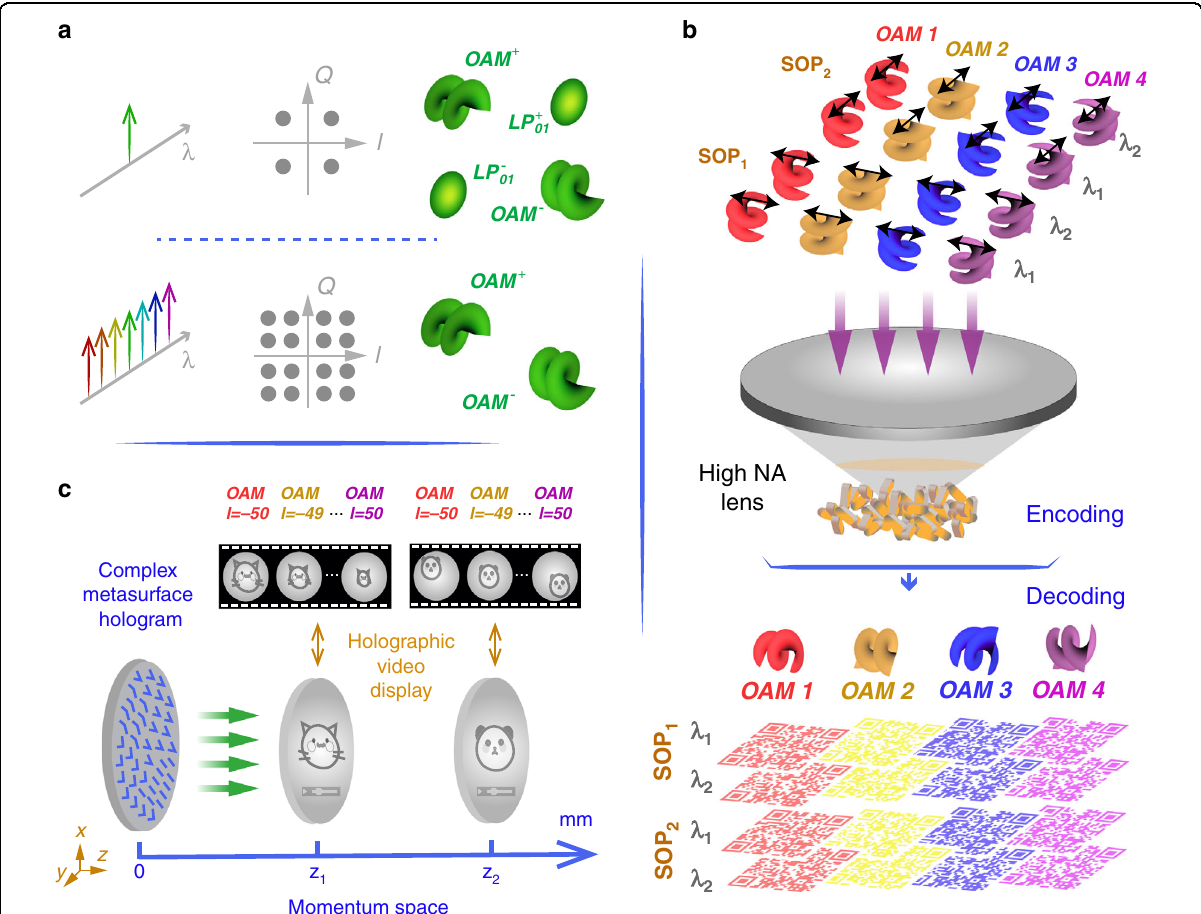
Fig. 3 Illustrations of higher-dimensional structured light multiplexing. a Multiple wavelengths multiplexing in OAM-based optical communication. b Schematic of the OAM-based six-dimensional encoding and decoding process of nanometric QR codes utilising the combinations of four different OAM states. P polariser, QWP quarter-wave plate, SOP state of polarisation, λ wavelength. c Complex-amplitude OAM-multiplexing metasurface hologram with optically addressable holographic video display at two image